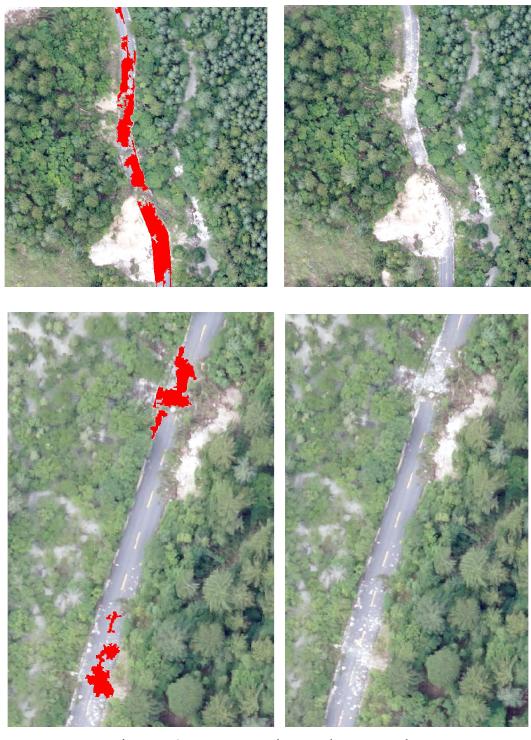
Figure 9. Damaged Road